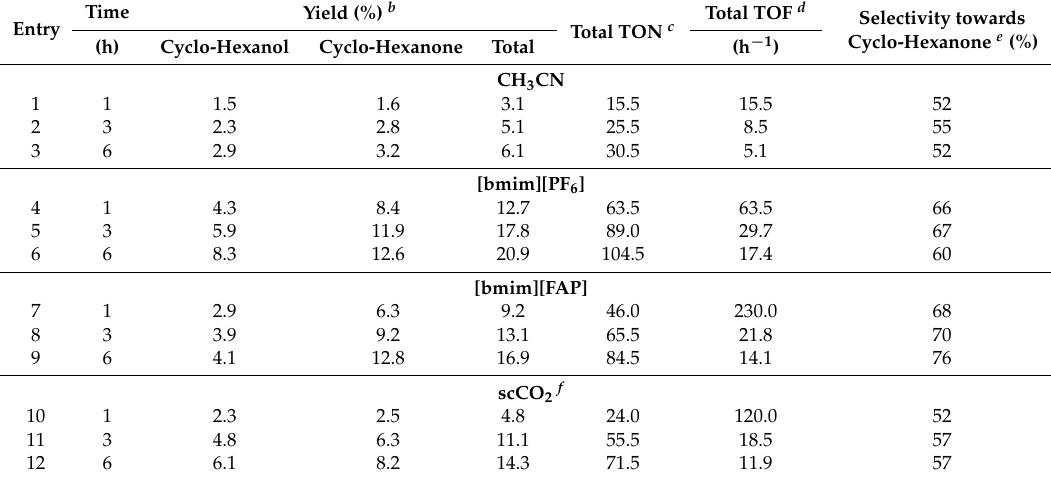
Table 1. Selected data a for the cyclohexane oxidation with TBHP using [FeCl 2 {HC(pz) 3 }] 1 as a catalyst. Time Entry